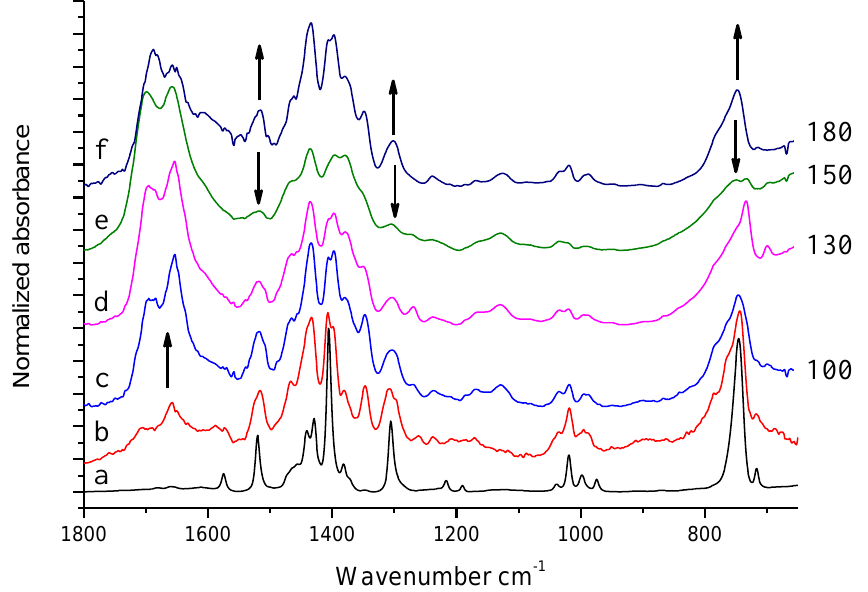
Figure 9. Experimental spectra of pristine TMP ( a ), reference spectrum of modified TMP (sample treated at 130 °C-residue after evaporation)) ( b ), solid powder of HSAG/TMP mixture isolated after the reaction of TMP with the catalytic amount of HSAG ( c )–( f ). On the right side of the Figure, treatment temperatures (°C) are indicated.